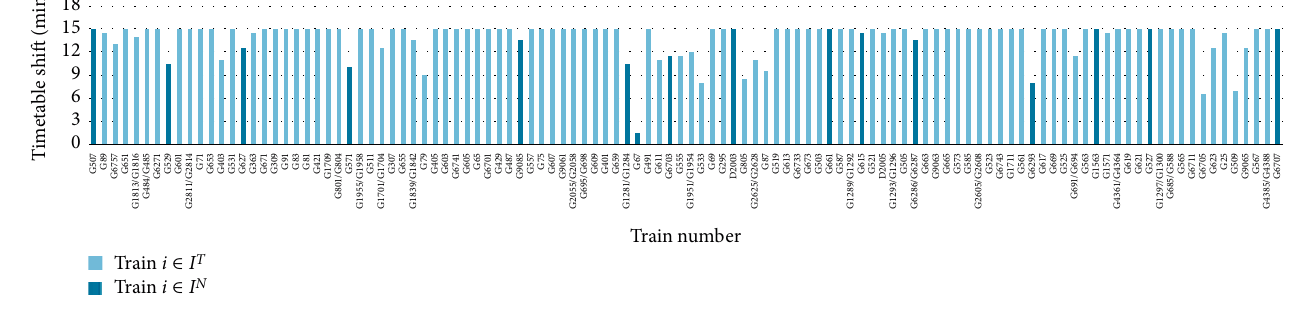
Figure 7: Time shift of each